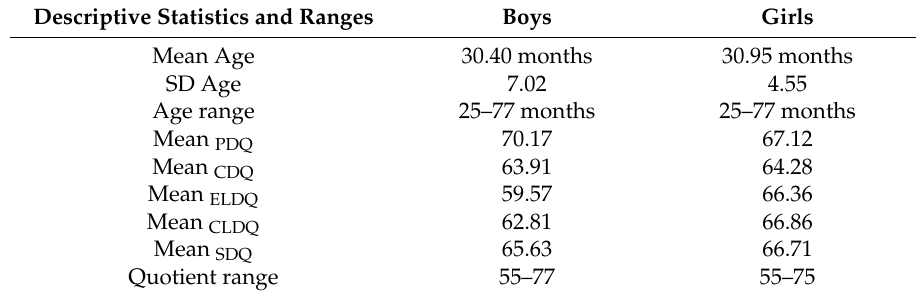
Table 1. Participants´ Mean and Standard Deviation (SD) in Brunet-Lezine and Reynell Quotients. Descriptive Statistics and